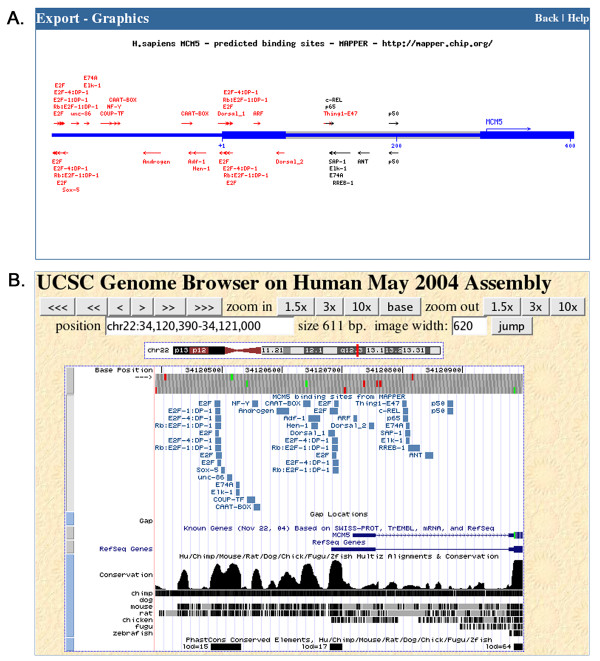
Different representations of the set of putative TFBSs in the human MCM5 gene promoter. A. Graphical representation of the hit set presented in Figure 3. B. The hit set was exported to the UCSC Human Genome Browser as a custom track. The region displayed in this image extends to 500 bp upstream of the coding sequence start. Note that the clusters of predicted binding sites correspond to peaks in the human/mouse conservation track at the bottom, suggesting that those regions are functional. The positions of the most conserved elements displayed in the conservation track are the ones used in the previous page to highlight hits in evolutionary conserved regions (see Methods for details).